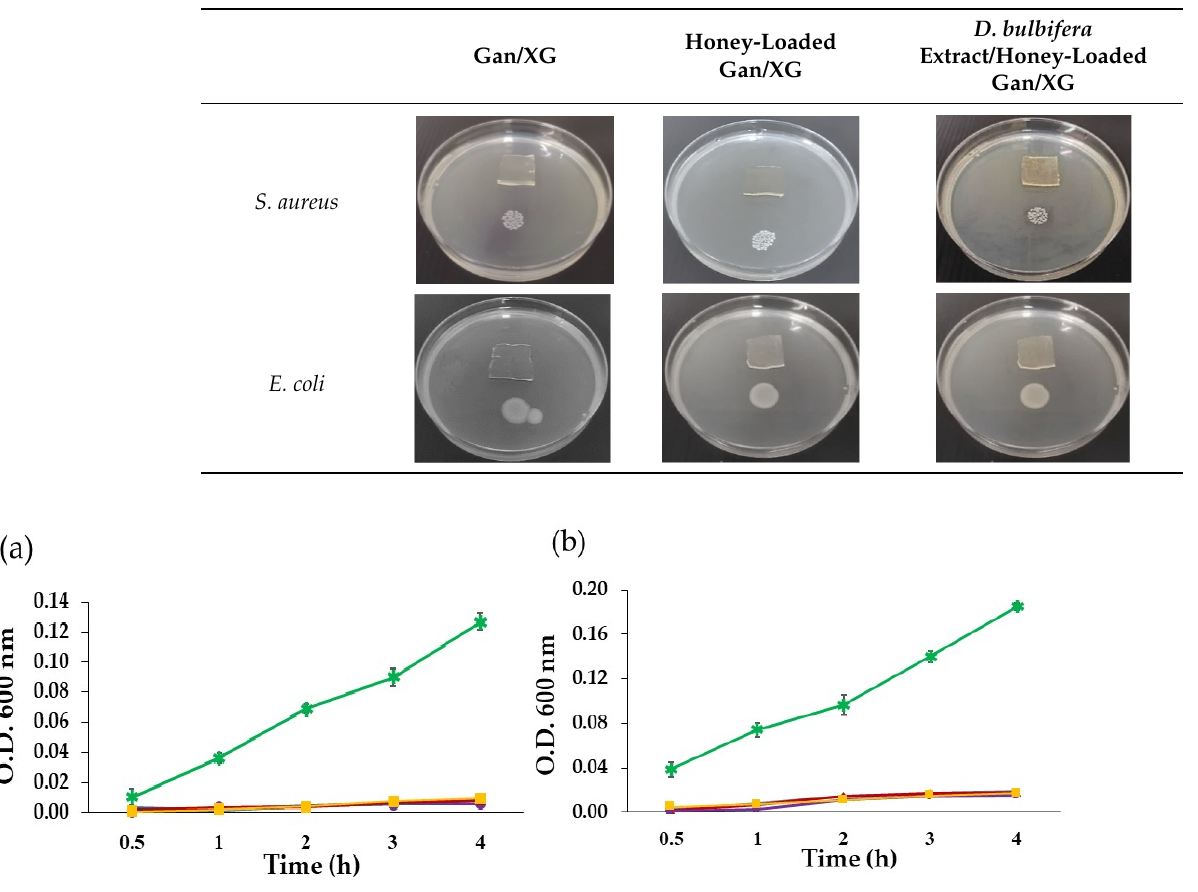
Table 5. Infiltration test of the hydrogel patches.